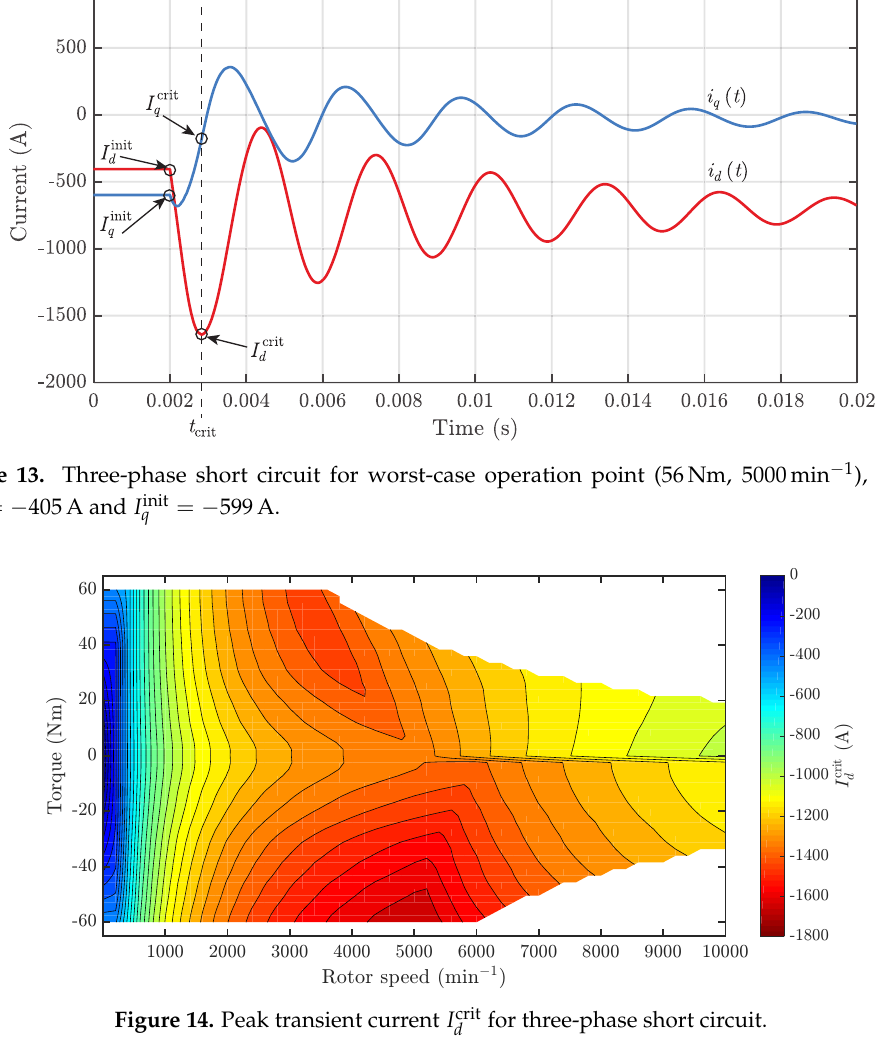
for three-phase short d